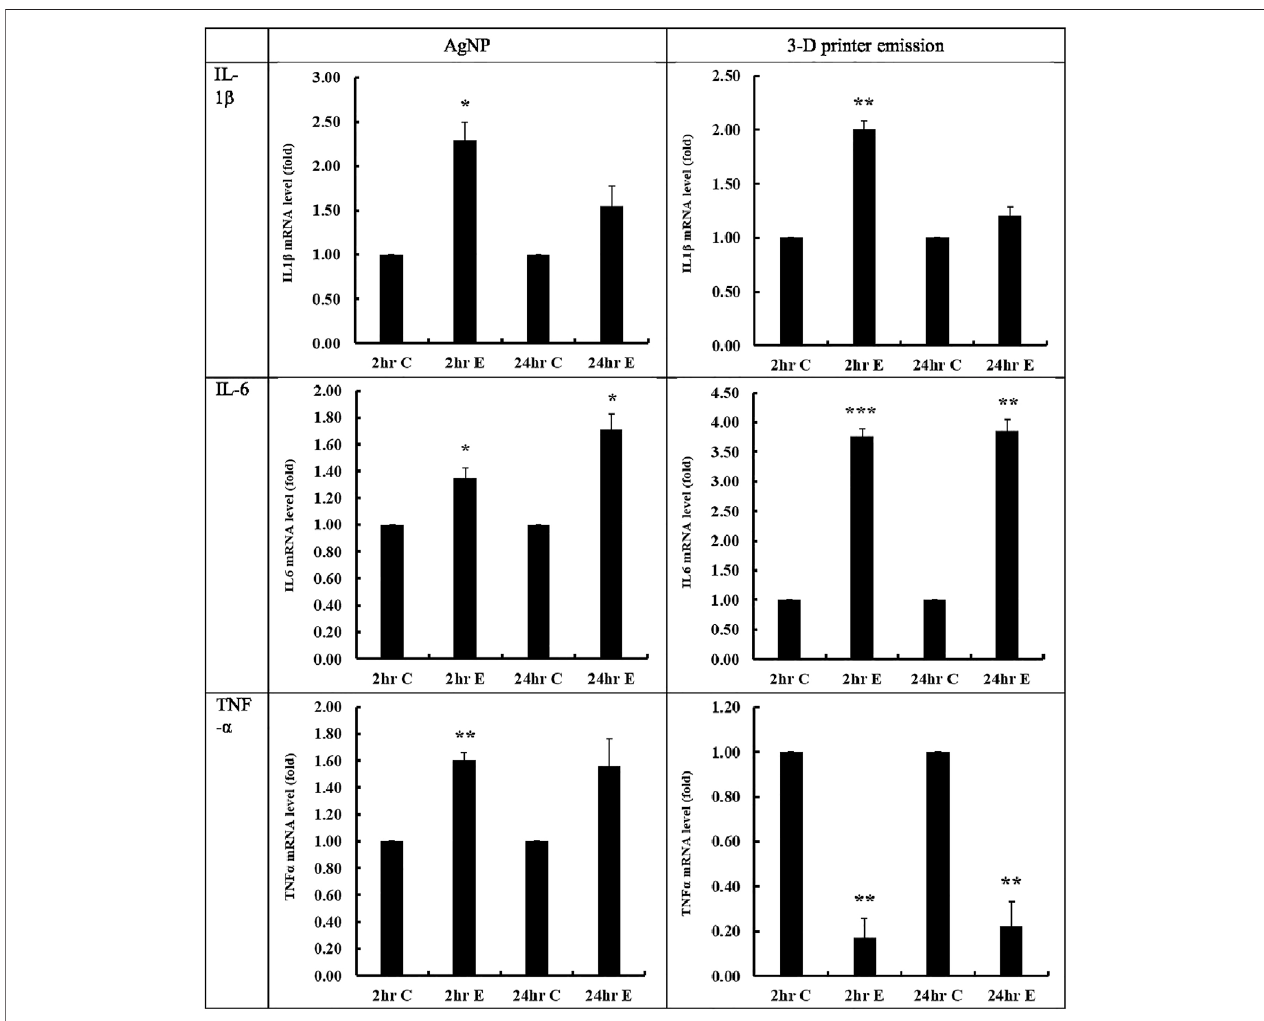
FIGURE4| In fl ammatory cytokine levelsafter AgNP and 3-Dprinteremission.mRNAlevels ofIL-1 β , IL-6,and TNF- α weremeasured after2-h exposure and post- exposure24-h incubation. 2C,2-h control; 2E,2-hexposure;24C, post-exposure24-hcontrol; 24E,post-exposure24 h; *, p < 0.05; **, p < 0.01; ***. p < 0.001. n =3).